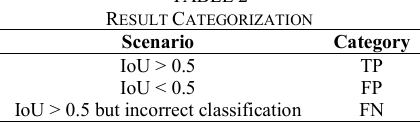
TABLE 2 R ESULT C